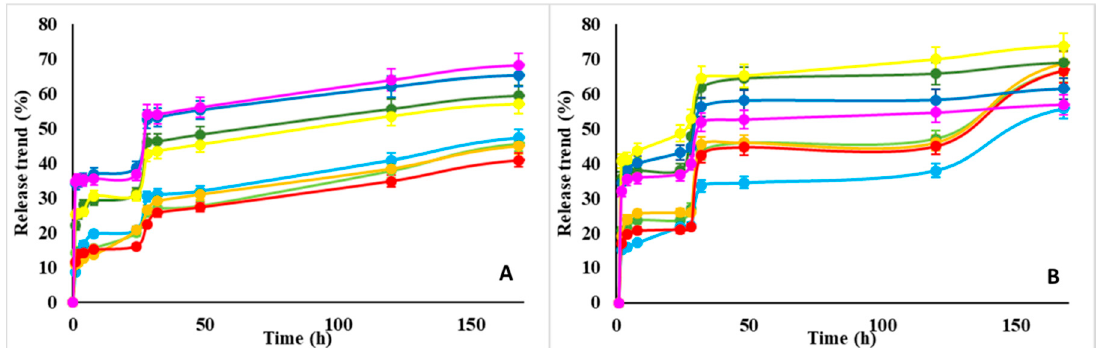
Figure 4. NMP desorption trend—Protein percent release by d-NMP (plot A) and w-NMP (plot B). Lysozyme: CM-dextran in light green, hyaluronic acid in light blue, alginate in orange, dextran in red. BSA: CM-dextran in dark green, hyaluronic acid in blue, alginate in yellow, dextran in pink. The comparison between loading and release efficiency for Lysozyme and BSA in Figure 3 and Figure 4 indicates the following.